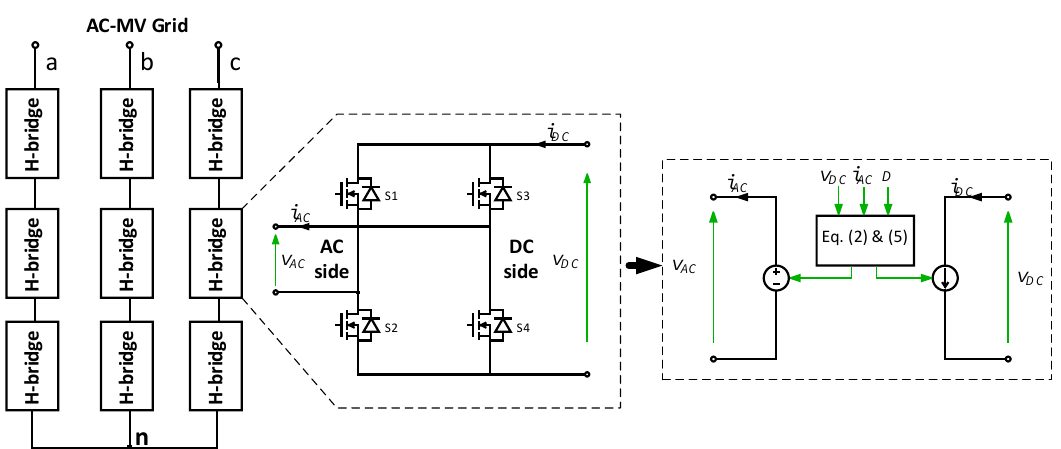
Figure 3. The scheme of the cascaded H-bridge converter used in the ST—full switching and average models of the single module.